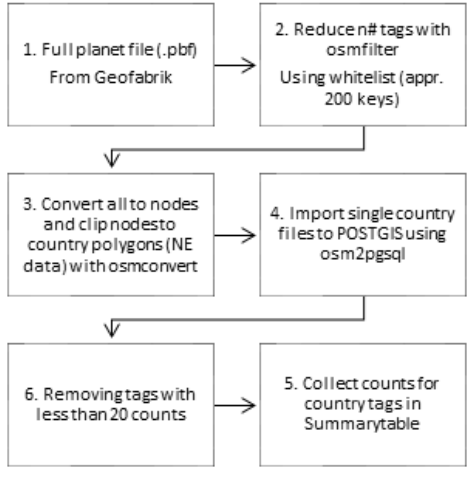
Figure 1: Data preprocessing